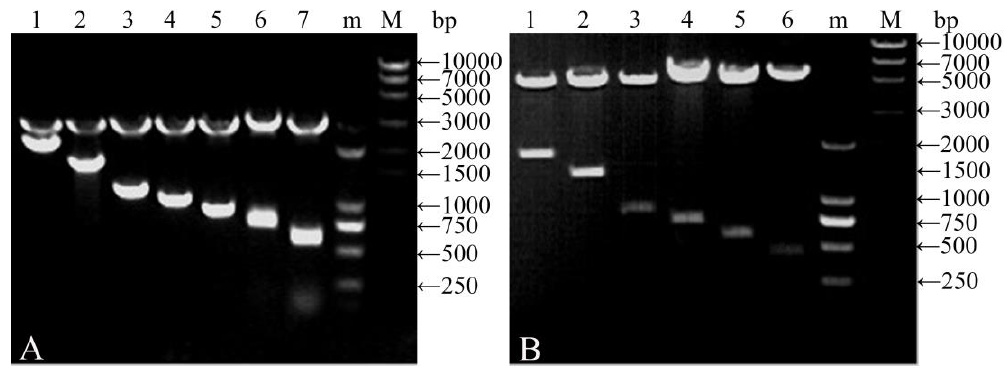
Figure 2. DNA gel electrophoretogram of clone plasmids digested with Bgl II/ Hind III ( A ) and expression vectors digested with Bam HI/ Hind III ( B ). (M and m): DNA molecular weight standards.